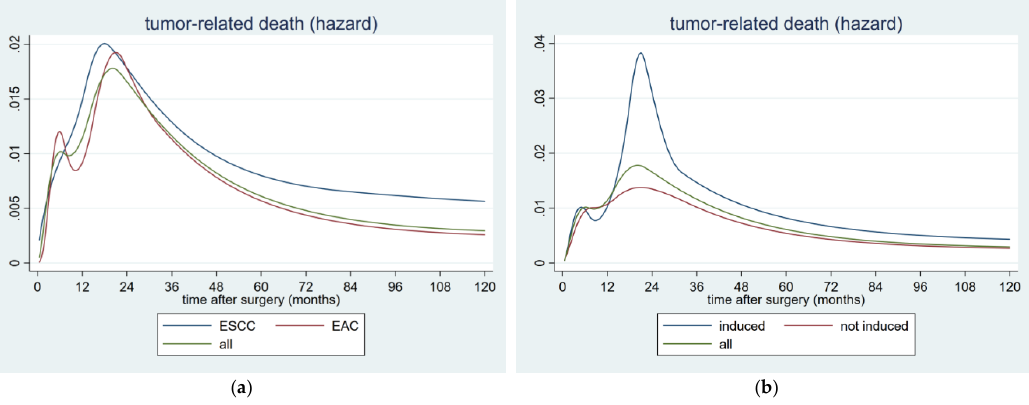
Figure 3. Hazard rate for postoperative tumor-related death in 362 patients with resected esophageal cancer stratified by ( a ) histology and ( b ) induction treatment. Abbreviations: EAC: esophageal adenocarcinoma and ESCC: esophageal squamous-cell carcinoma.